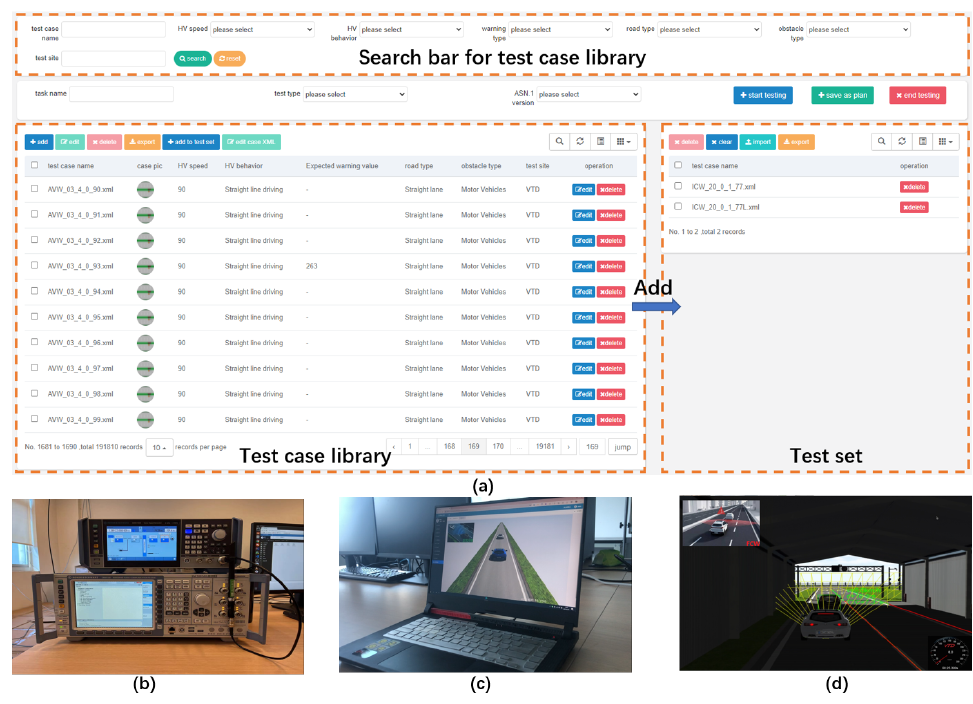
Figure 14. ( a ) Test case administration interface ( b ) Signal generators and server ( c ) Client display in safe driving situations ( d ) Client-side display of forward collision warning and sensor effect.